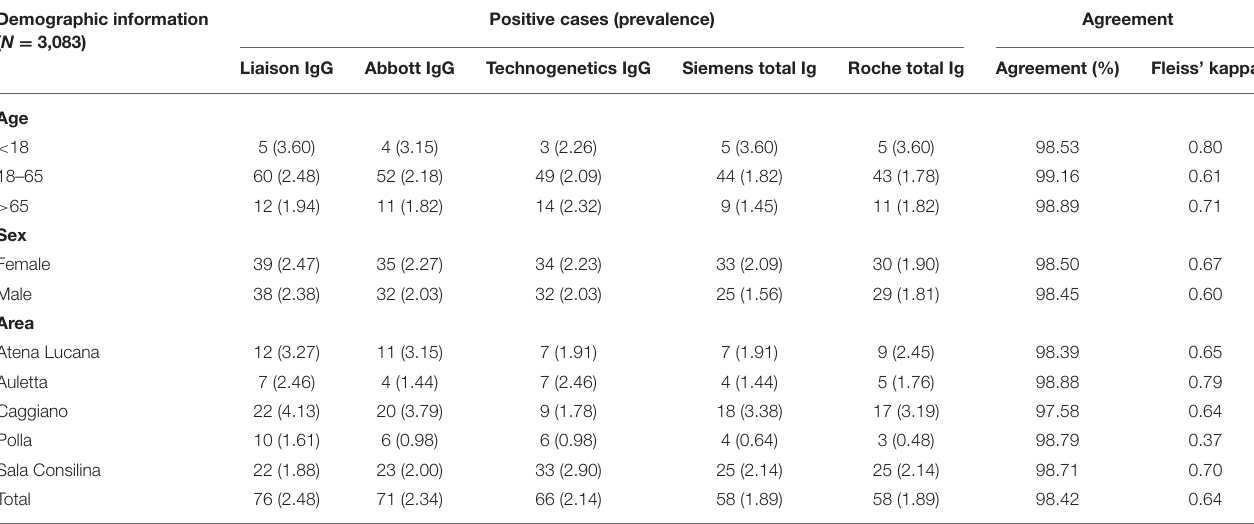
TABLE 1 | Absolute number and prevalence of COVID-19 infections as measured by the different serological tests grouped by age, sex, and area. Demographic information ( N =